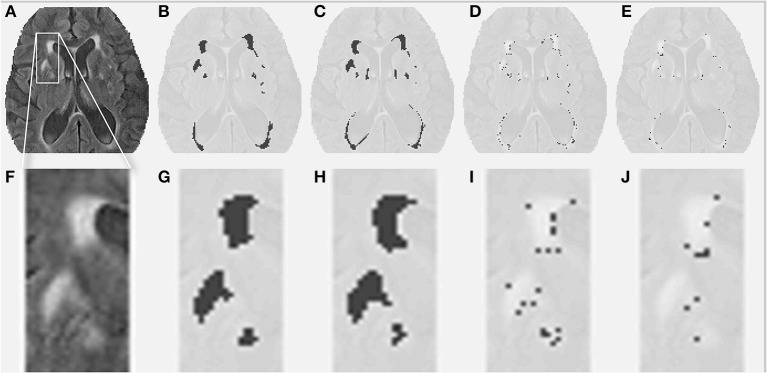
White matter lesions (WML) at a middle level height. (A) FLAIR image for a given subject. (B) Conventionally estimated WML. (C–E) Estimated WML, using the proposed segmentation algorithm, for full, intermediate, and small proportion of lesion. (F–J) Similar images for the zoomed portion depicted by the white box in (A).